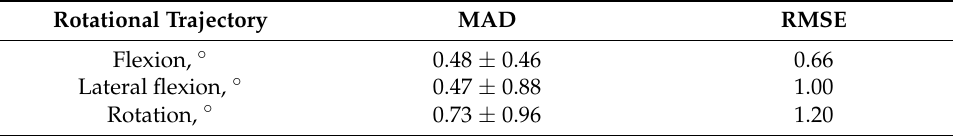
Table 4. Results for the rotational trajectories.